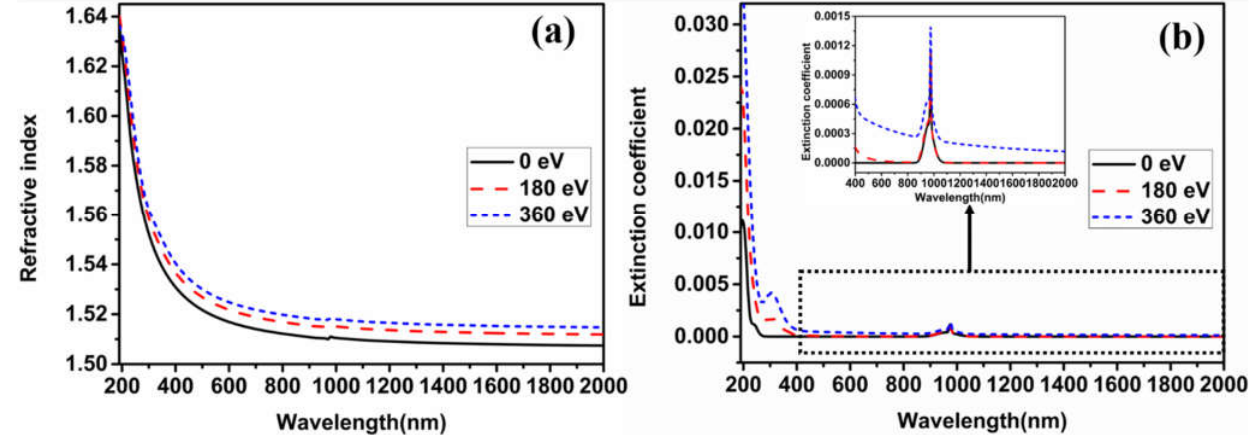
Figure 5. Optical constants of YbF 3 films from 190 nm to 2000 nm. ( a ) Refractive index. ( b ) Extinction coefficient.